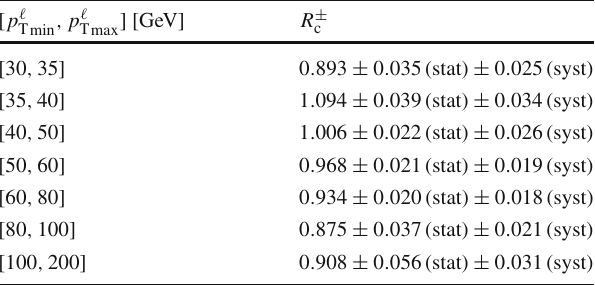
Table 10 Measured cross section ratio R ± c as a function of p (cid:3) the combination of all four